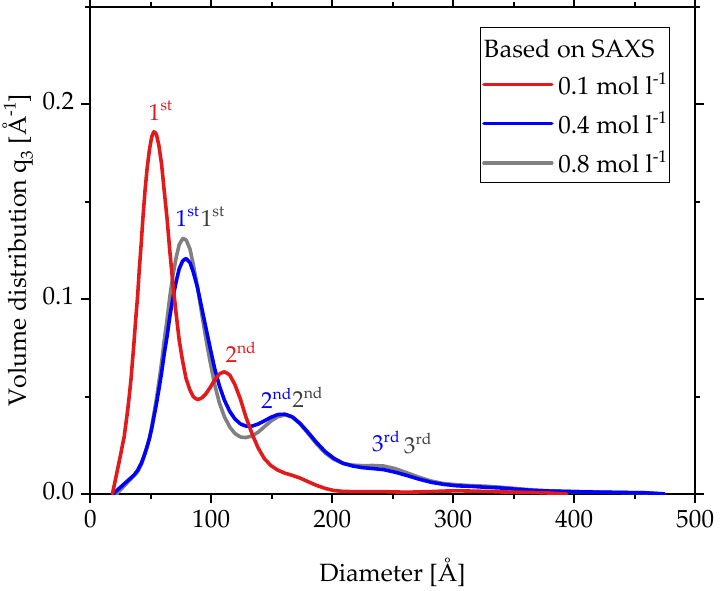
Table 2. Diameters of the peak positions of the volume size distribution calculated from SAXS data of Figure 6.